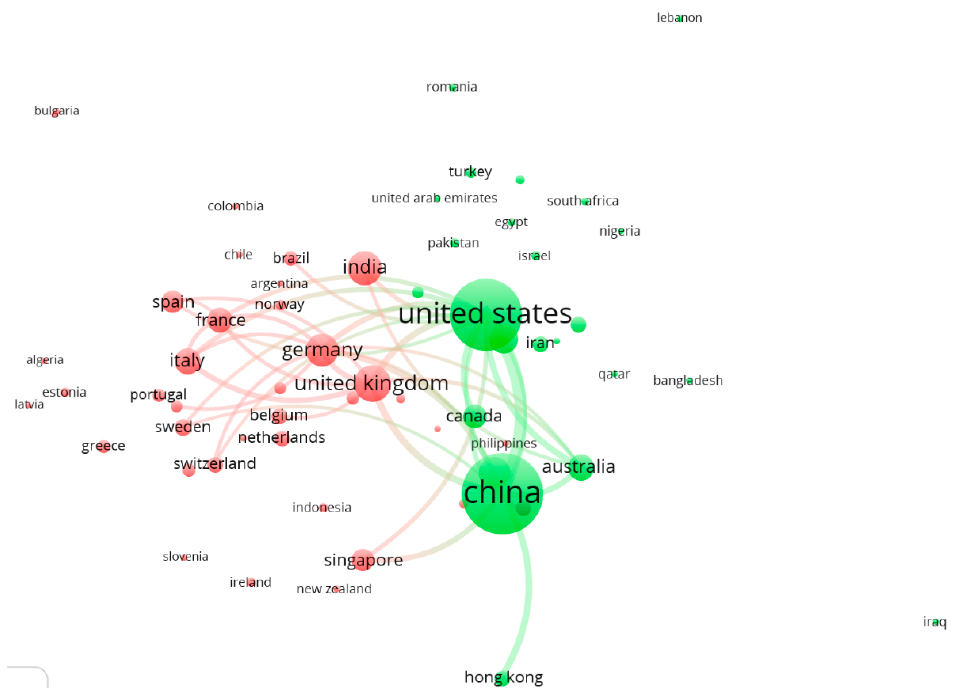
Figure 3. Clustering of the countries’ collaborations and their reciprocal links. Clustering is based on the authors’ addresses. Different colors represent different countries’ clusters (only the first 50 linkages in terms of relevance were illustrated).